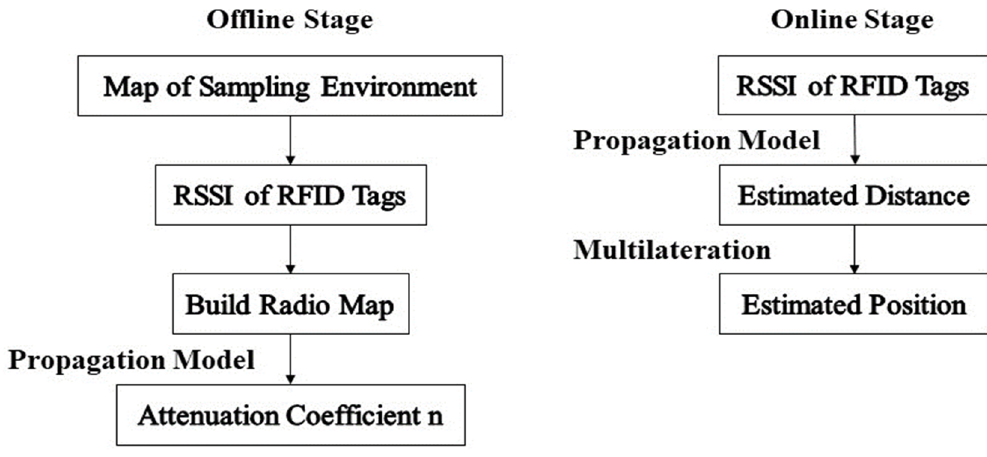
Figure 1. Block diagram of the offline and online stages .